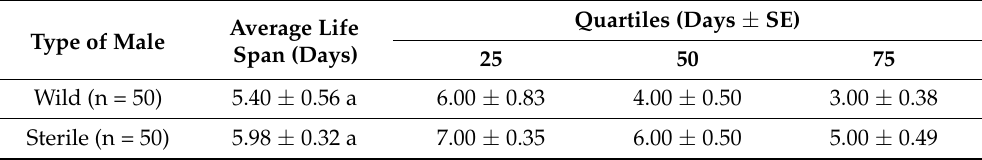
Table 3. Response (time to death) of wild and sterilized Aedes albopictus males under food stress conditions (only